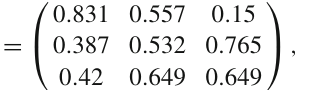
= 0 . 051eV in NH 3